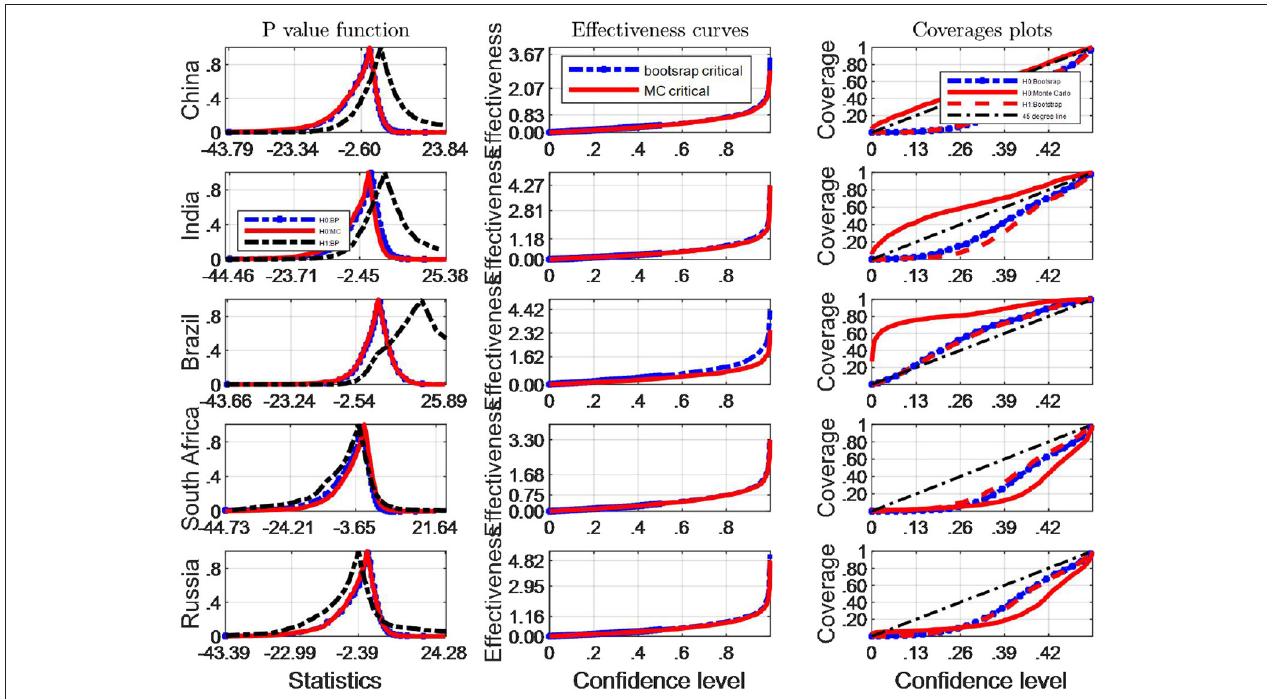
FIGURE 3 | A comparison of confidence intervals of Monte Carlo and counterparts of bootstrap for the Robinson test using EF indicators.